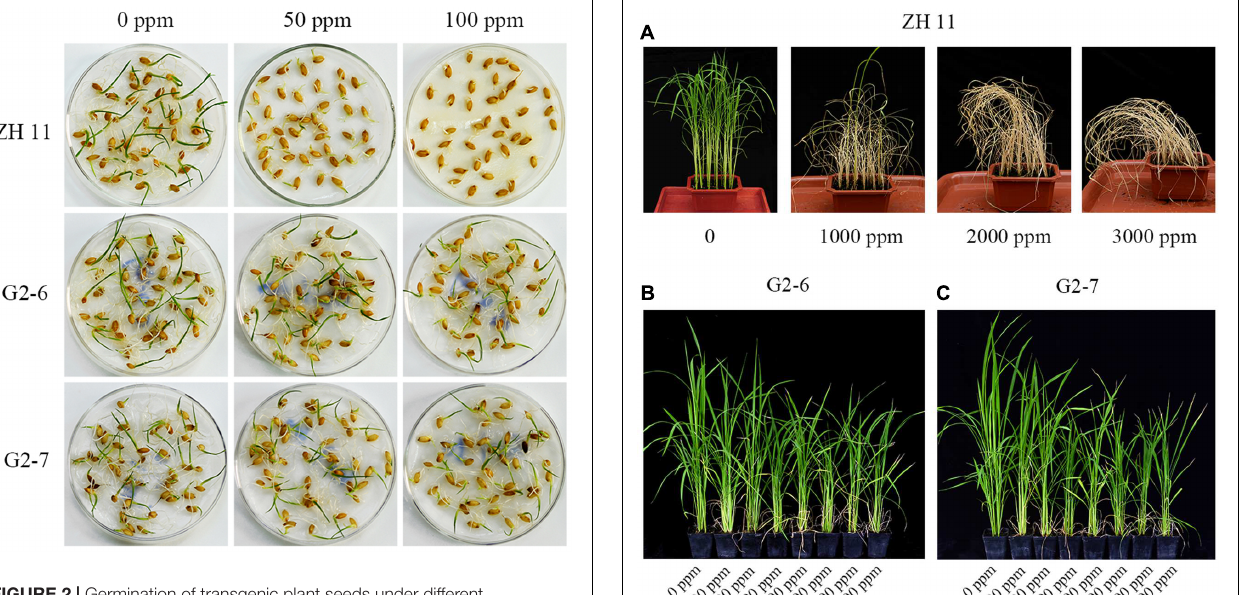
FIGURE 2 | Germination of transgenic plant seeds under different concentrations of glyphosate. Sprouting of homozygous transgenic lines (G2-6, G2-7) on ultrapure water containing 0, 50, or 100 ppm glyphosate for 6 days. FIGURE 3 | Rice growth phenotype under different concentrations of